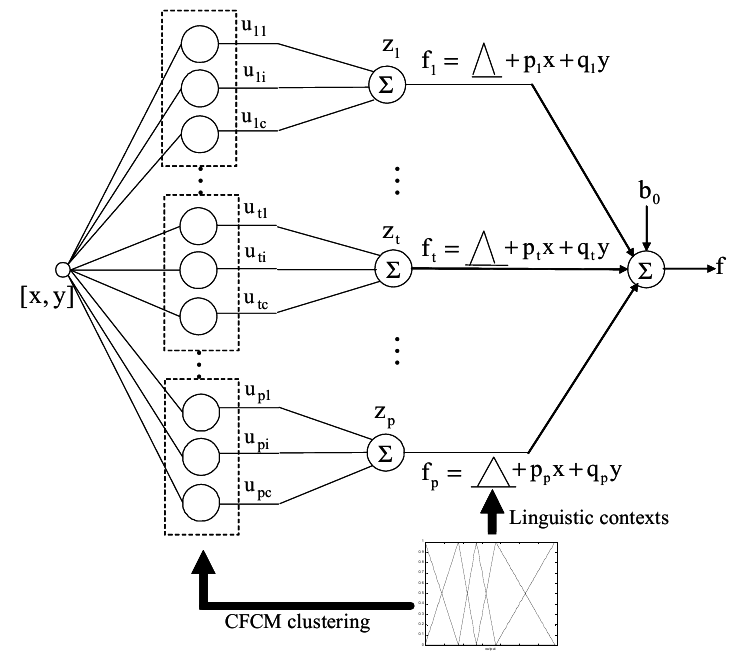
Figure 5. Architecture of TSK-LM as intelligence